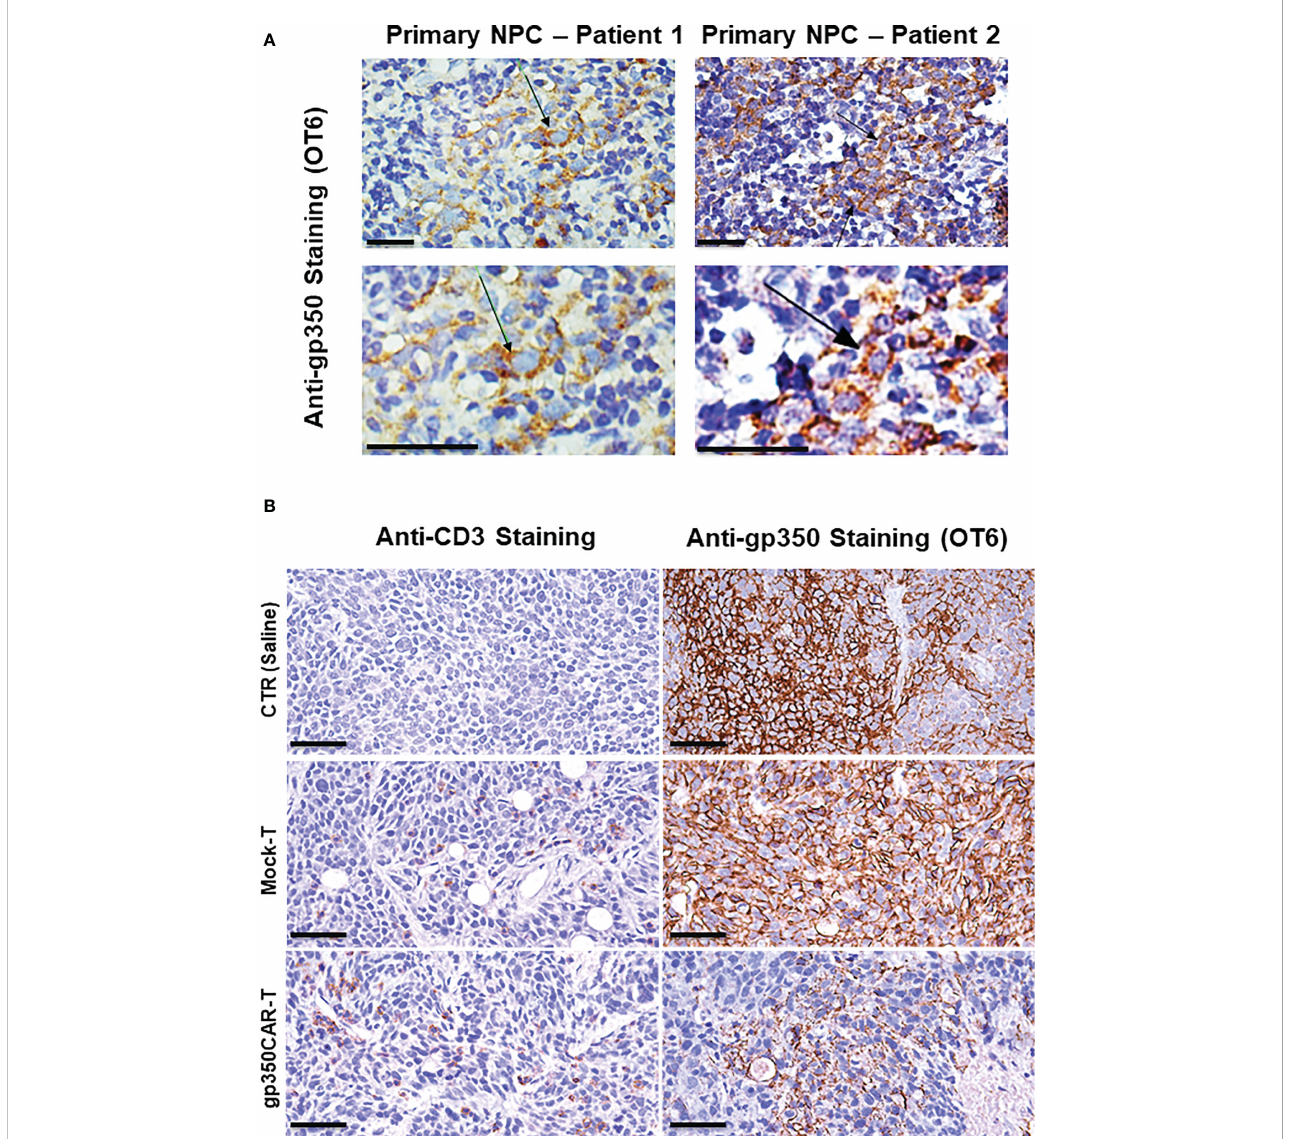
FIGURE 5 Immunohistochemistry staining of paraf fi n-embedded sections obtained from primary NPC patient tissues or obtained from a C666.1/gp350 tumor sample explanted from a mouse. (A) anti-gp350 OT6 staining on primary tumor biopsies from two NPC patients. Arrows, positive staining on tumor cell membrane. Scale bar, 50 m m. (B) Representative example of anti-human CD3 staining and anti-gp350 staining on C666.1/gp350 tumor samples. Additional two cases can be found in Figure S1. Scale bars represent 50 m